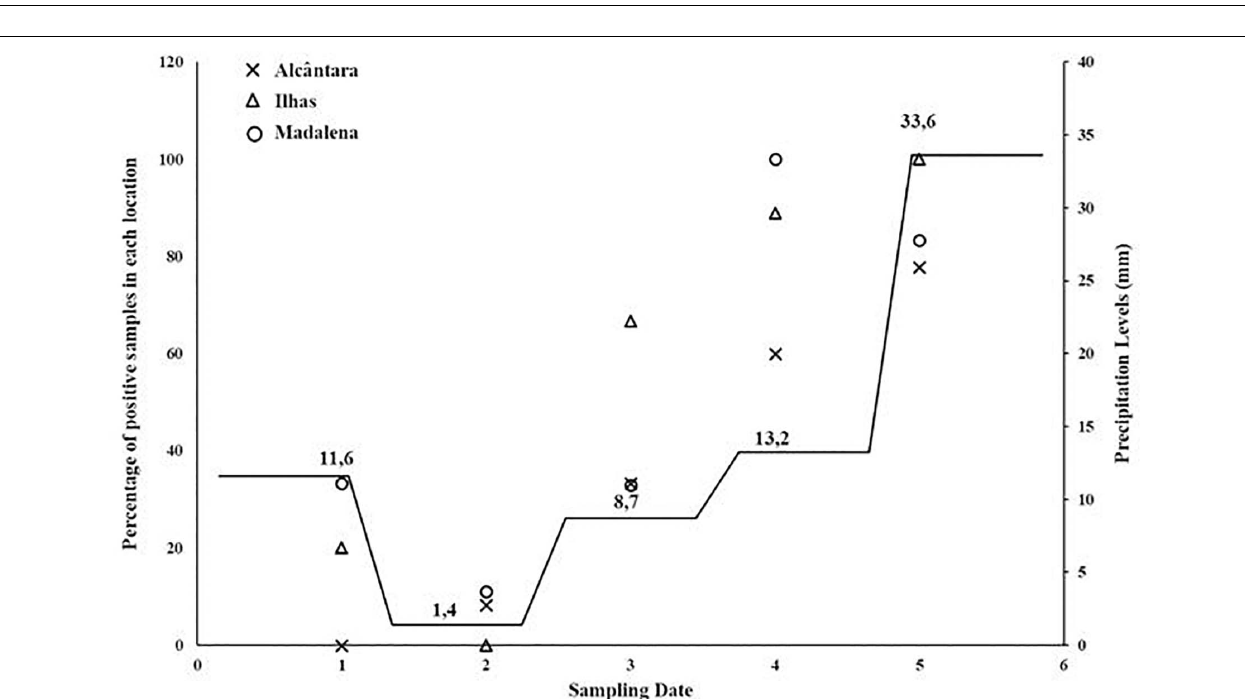
FIGURE 5 | Relation between the levels of precipitation and the percentage of detected MST assays per sampling